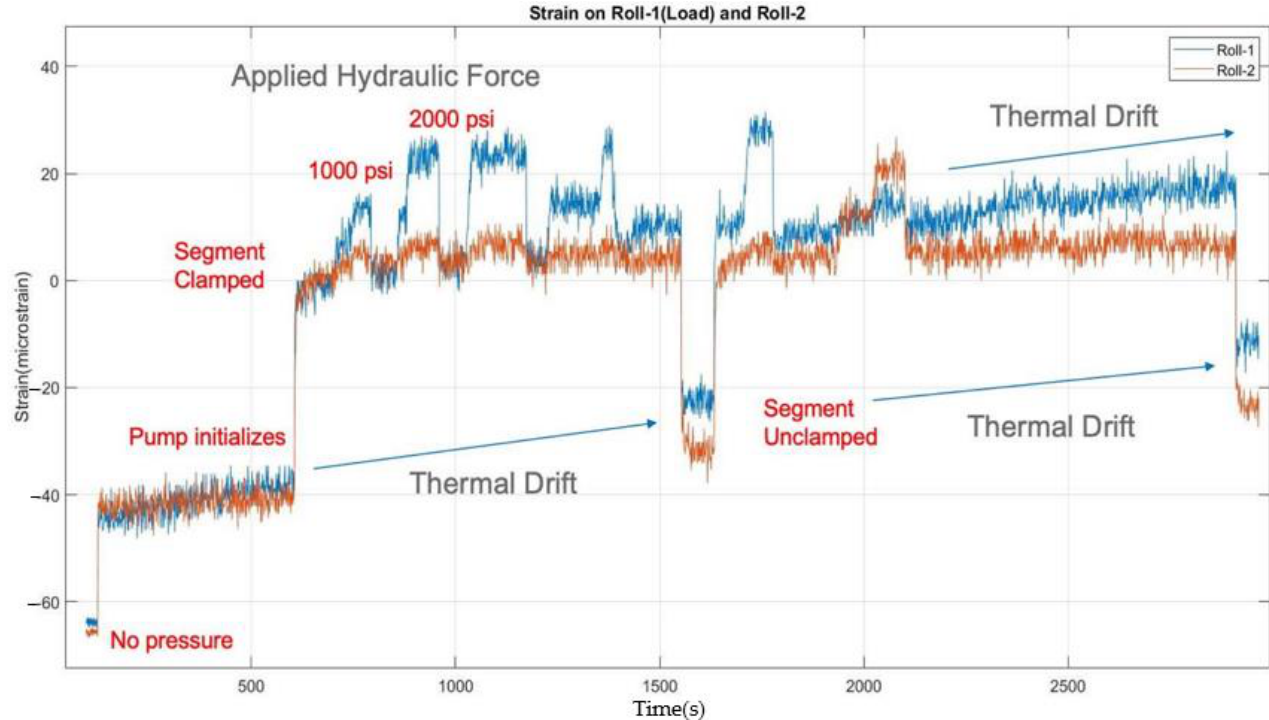
Figure 15. Strain measured with varying segment clamping pressures and hydraulic jack loads.